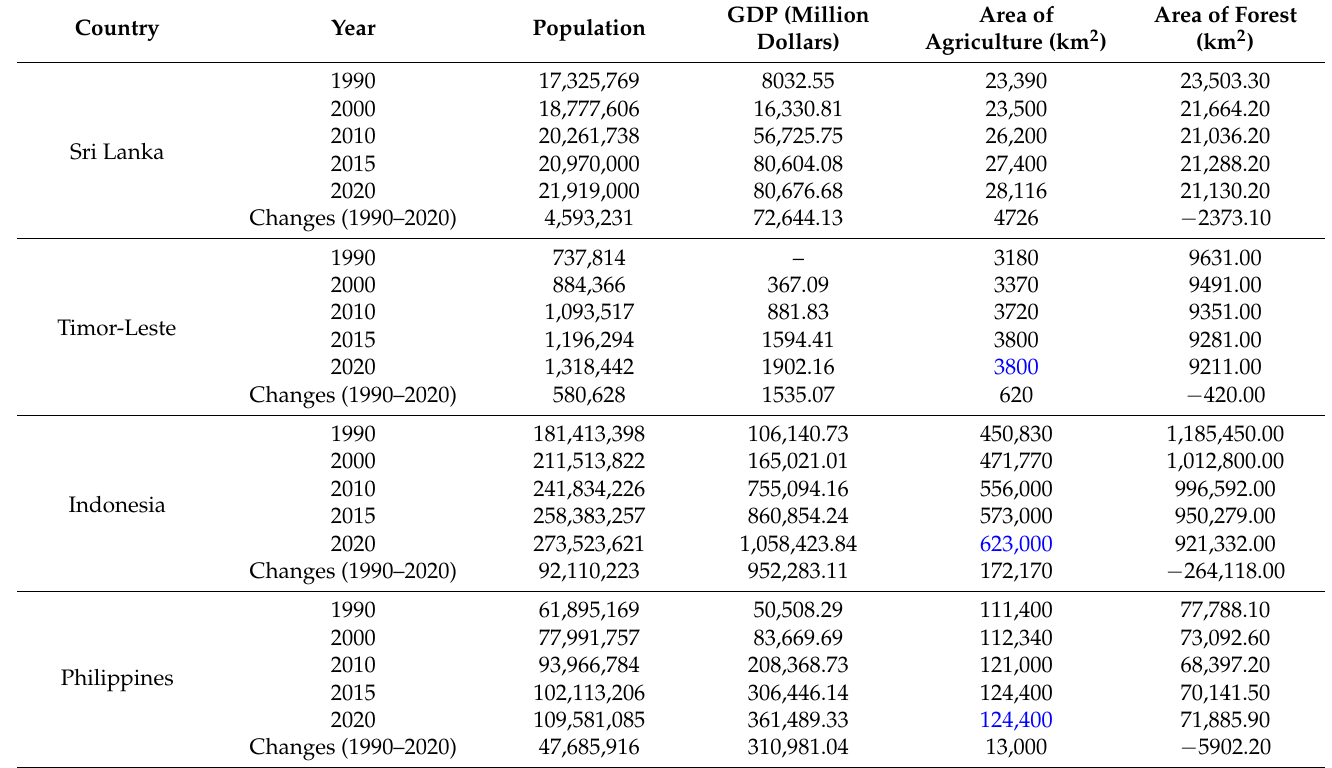
Table 5. Social and economic statistics of related countries from 1990 to 2020.